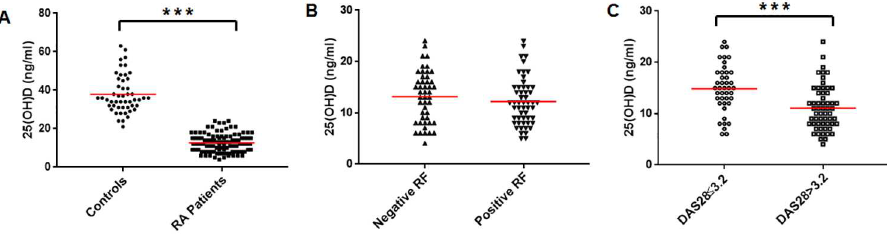
Fig 1. Serum level of 25-hydroxy vitamin D in controls and RA patients (Fig A), seropositive and seronegative RA patients (Fig B) and patients having DAS28 (cid:20) 3.2 and those having DAS28 > 3.2 (Fig C). ( *** p < 0.001).